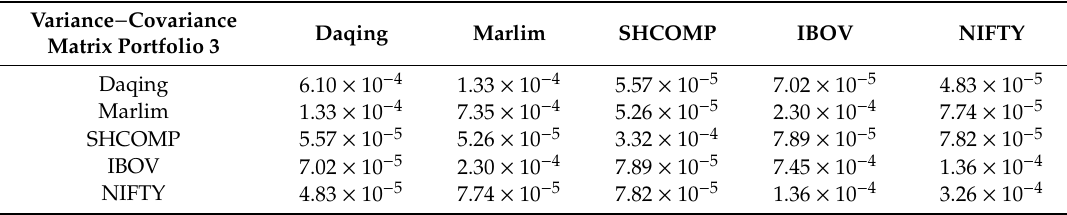
Table A27. Maximum Likelihood Variance–Covariance Matrices for portfolio 3: Daqing, Marlim, SHCOMP, IBOV, NIFTY. Elaborated by authors with data from